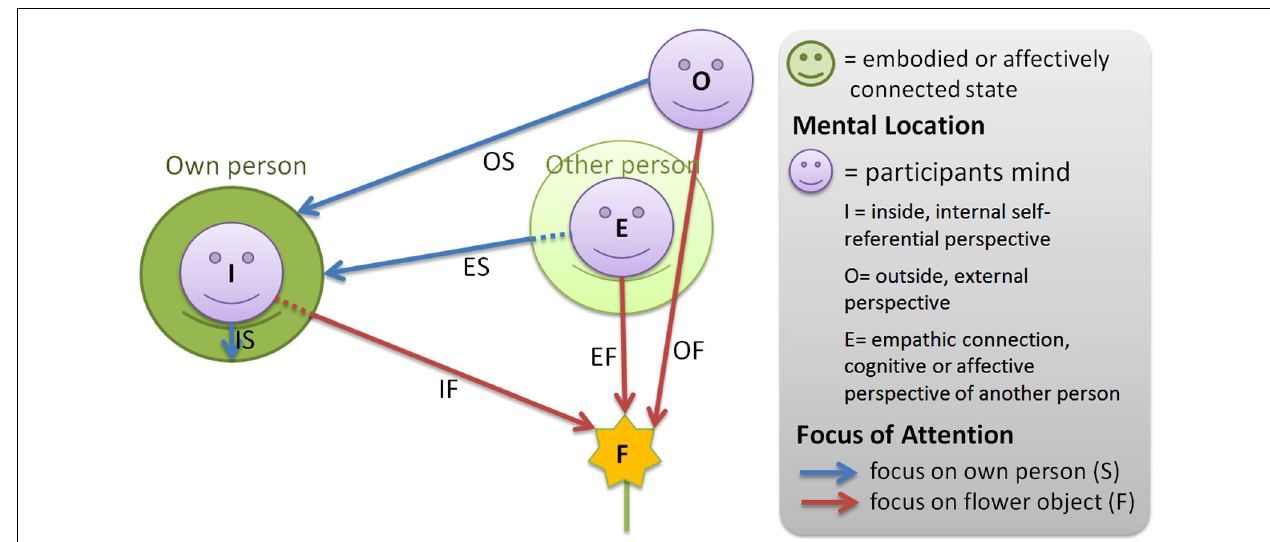
FIGURE 1 | Illustration of the 6 task conditions in this study. Participants were asked to adopt three different mental locations in which they focused either on their own body or on flowers in the room.The states are identified by two-letter acronyms describing location and focus.